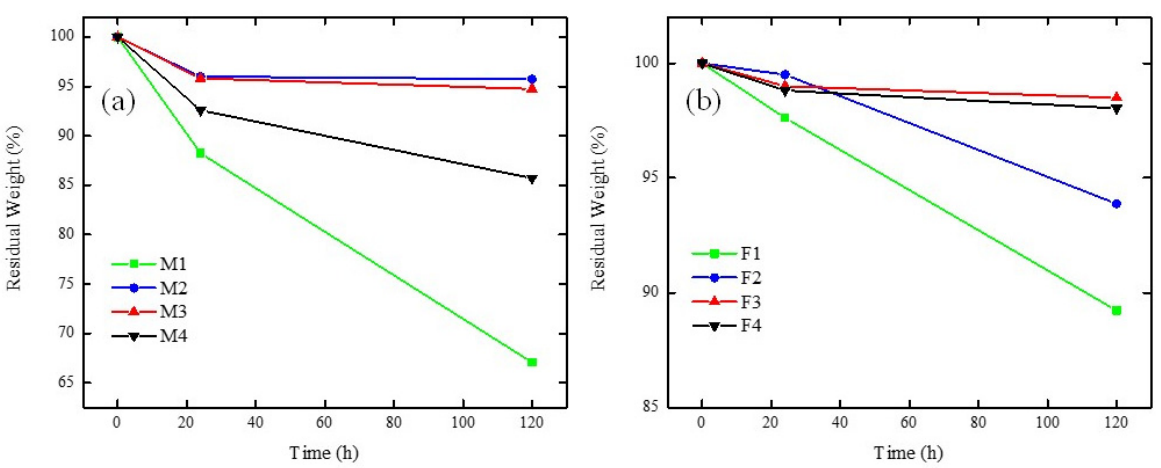
Figure 14. Oxidative stability for membranes containing: ( a ) PEI and ( b ) Fumion ® in Fenton reagent at 50 °C.